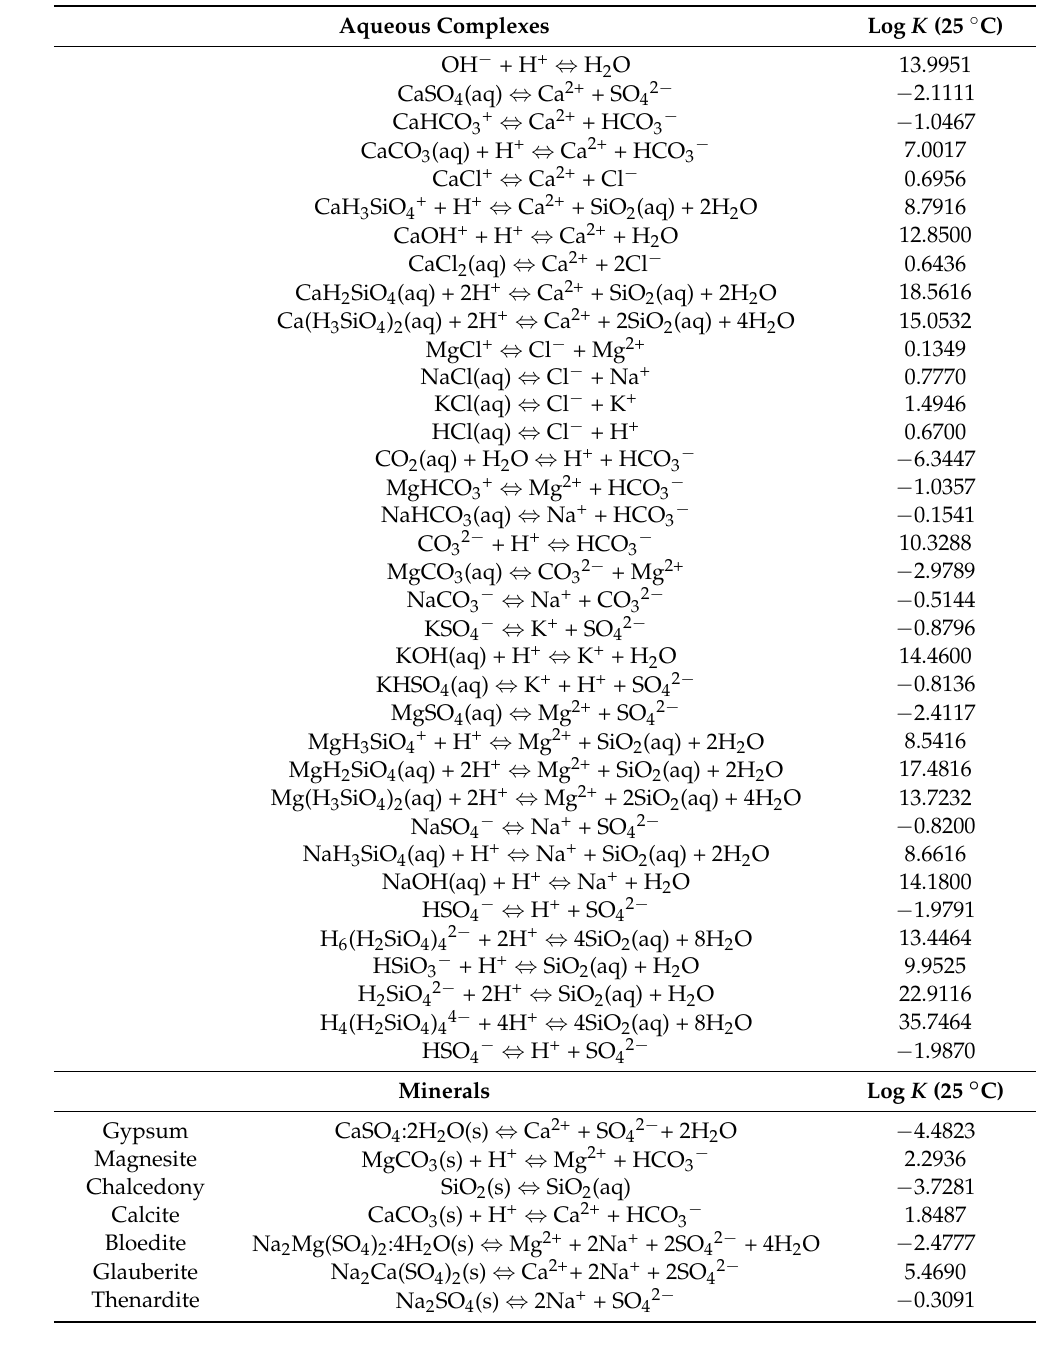
Table 1. Reactions and equilibrium constants for aqueous complexation and mineral dissolu- tion/precipitation reactions at 25 ◦ C considered in the 2-D reactive transport model (adapted from